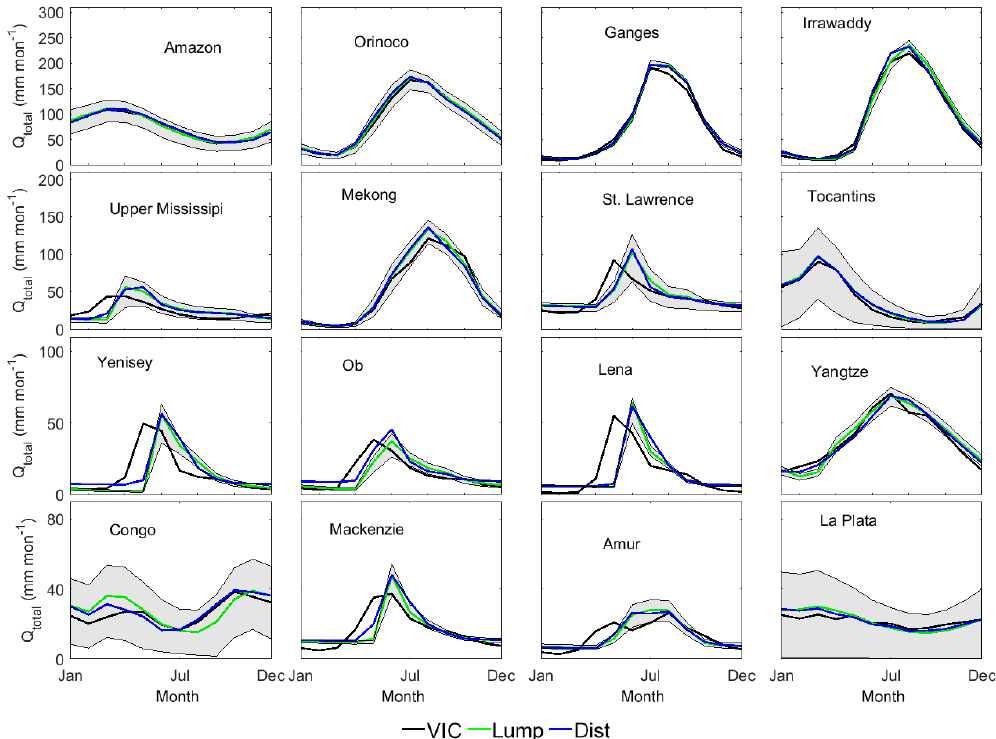
Figure 7. Parameter-induced uncertainty in total runoff estimate of the lumped abcd scheme for the world’s 16 river basins with top annual flow. The lines of VIC, Lump and Dist stand for the VIC benchmark runoff product and total runoff estimates from the lumped and distributed abcd scheme with the calibrated parameters, respectively, and the gray area represents the spread derived from variations in parameters of the lumped